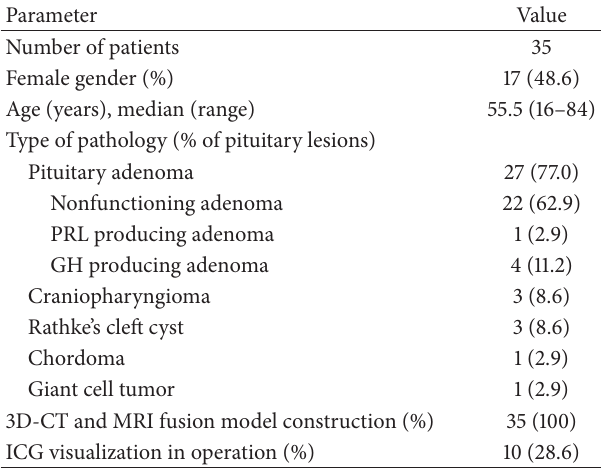
Table 1: Characteristics of patients enrolled in the study.